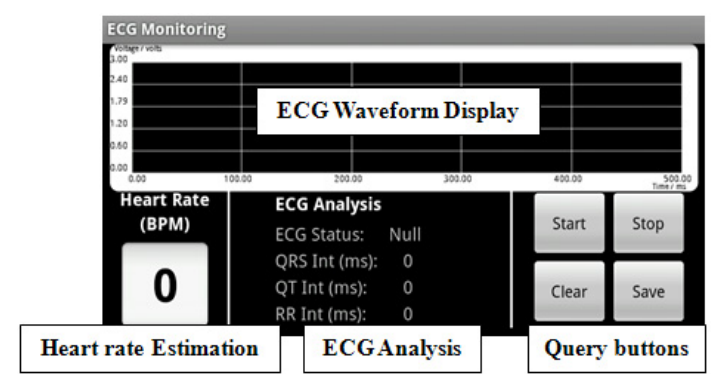
Figure 5. GUI of ECG monitoring system.